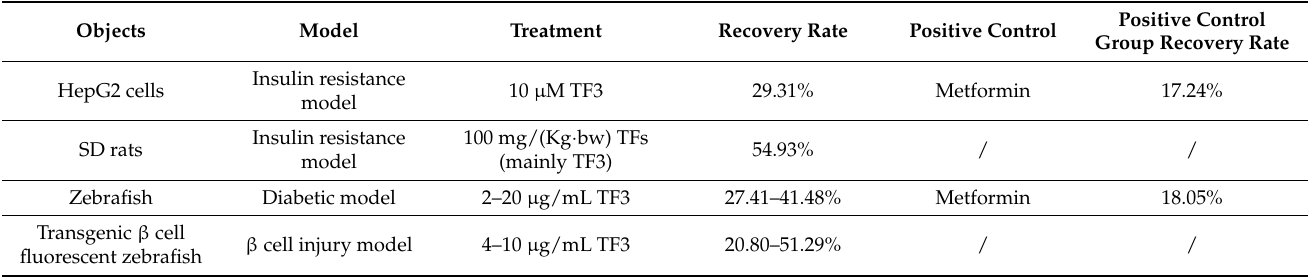
Table 1. Recovery effect of TF3 in different